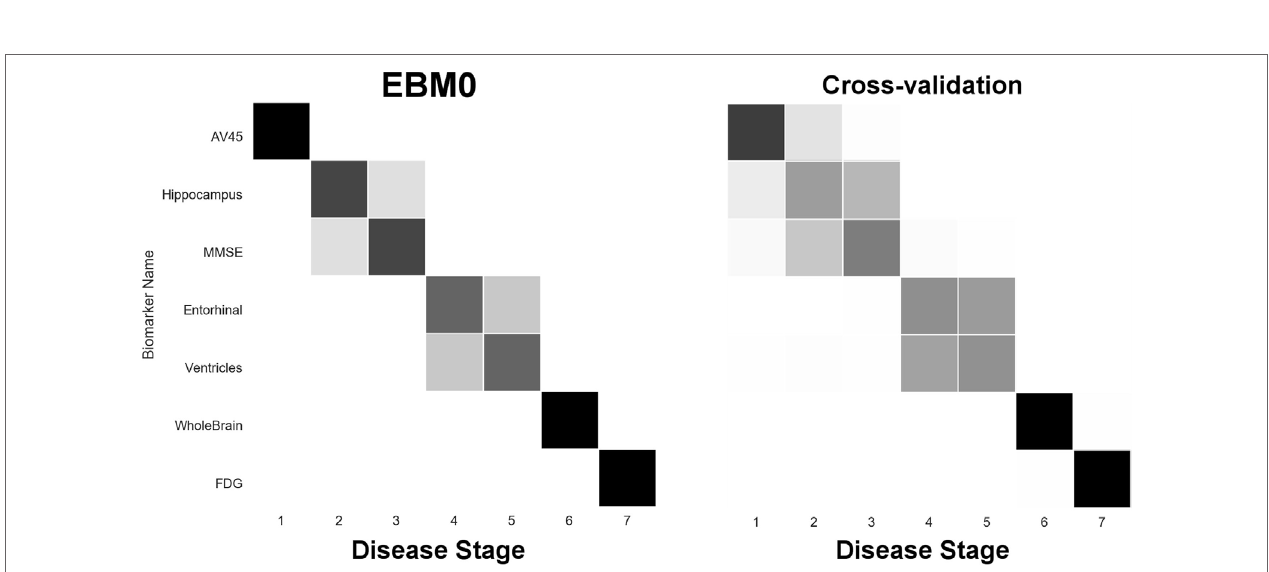
FigUre 4 | EBM for selected standard (non-network) biomarkers, built on available ADNI2 baseline data. Left panel: left-right positional variance of the maximum- likelihood sequence. Right panel: cross-validation of the sequence from